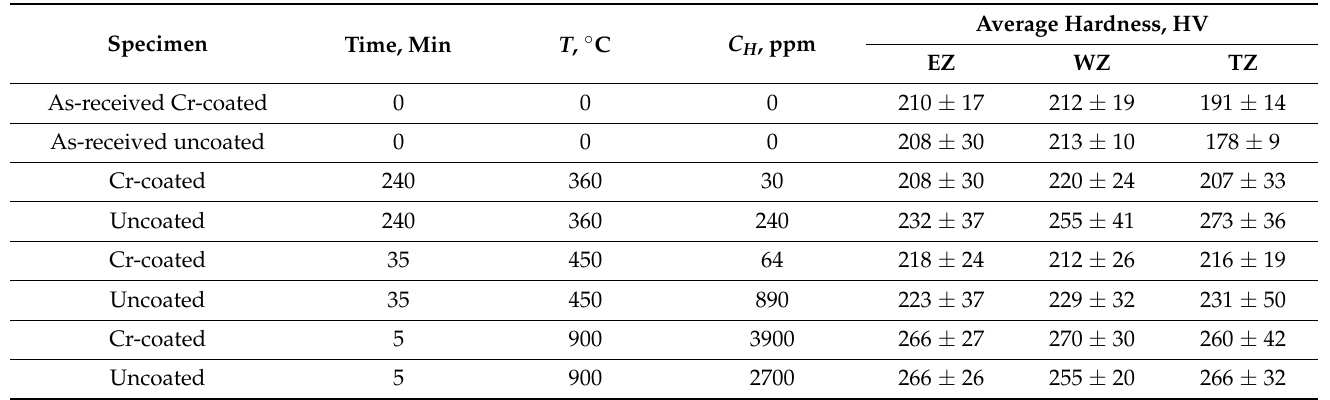
Table 2. Hardness of uncoated and Cr-coated RUW E110 alloy specimens.